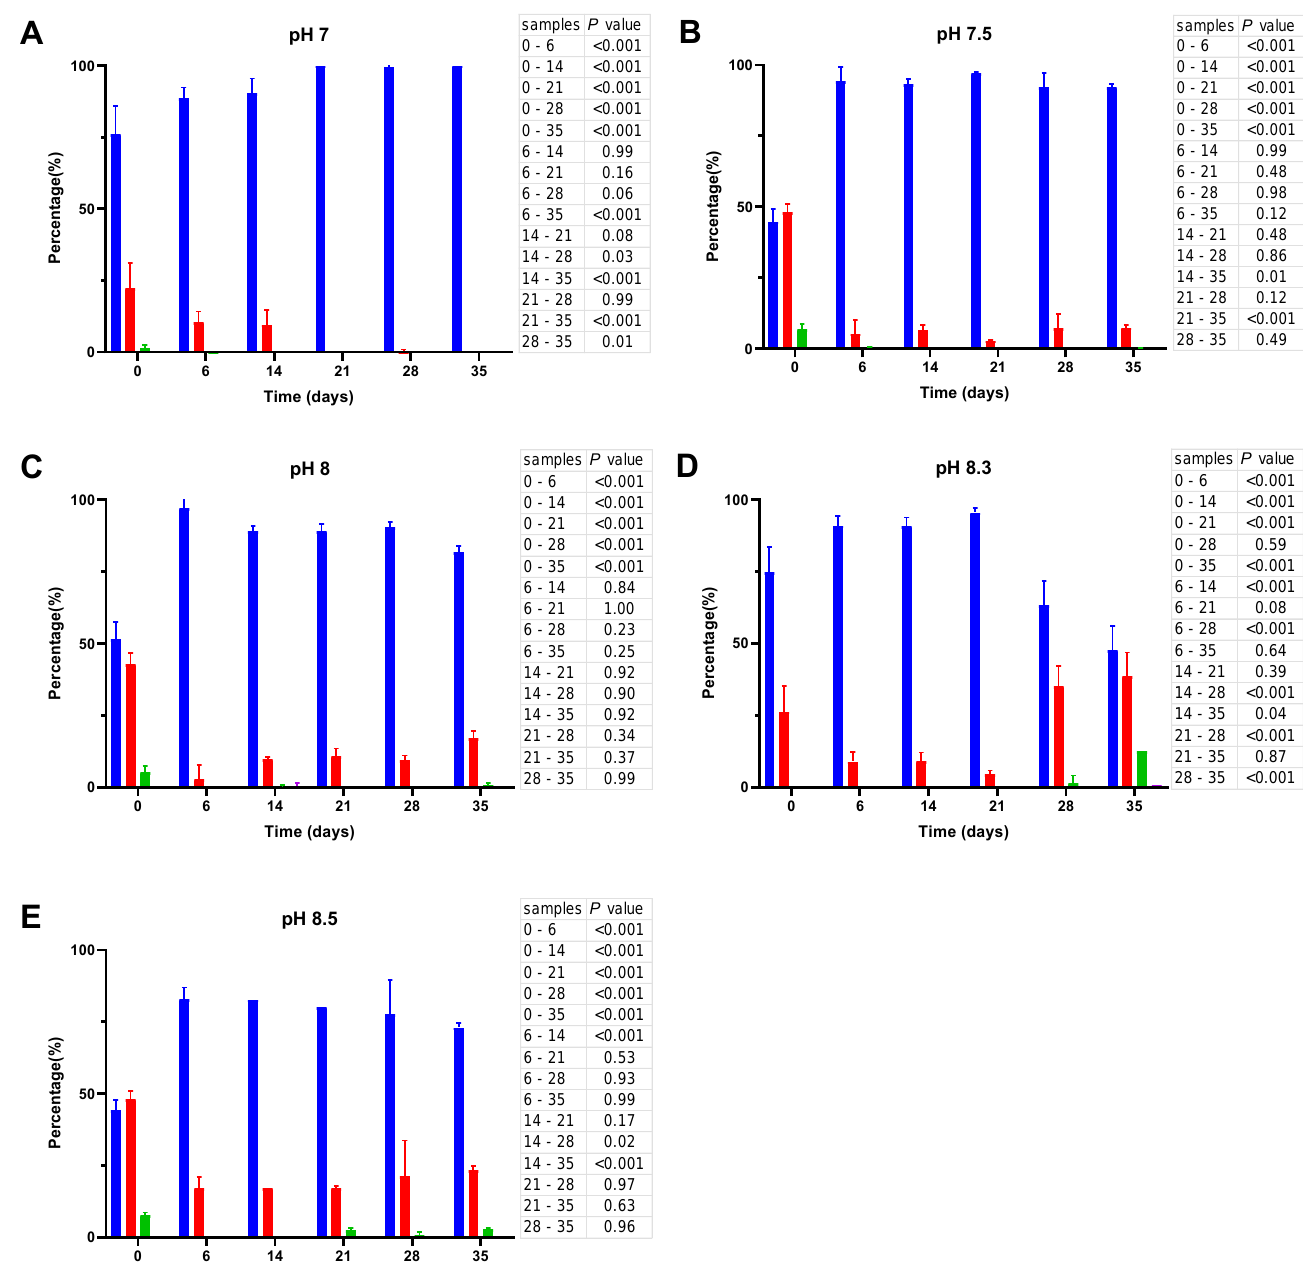
Figure 4. Cell size distribution at 20 °C. Cells are grouped according to their measured size ≤ 0.95 ( █ ); >0.95– ≤ 1.3 ( █ ); >1.3–1.6 ≤ ( █ ); >1.6 ( █ ). The blue bars represent the population of coccoid-like cells ( ≤0.95 μ m), whereas the cells with intermediate size and rod-like cells were arbitrarily placed in three additional groups indicated by red, green and violet bars. The data are mean values from three independent experiments with error bars representing the standard deviations. Statistical tests were performed to carry out the pairwise comparisons of the cell sizes datasets and the corresponding p -values are shown on the right of each panel.